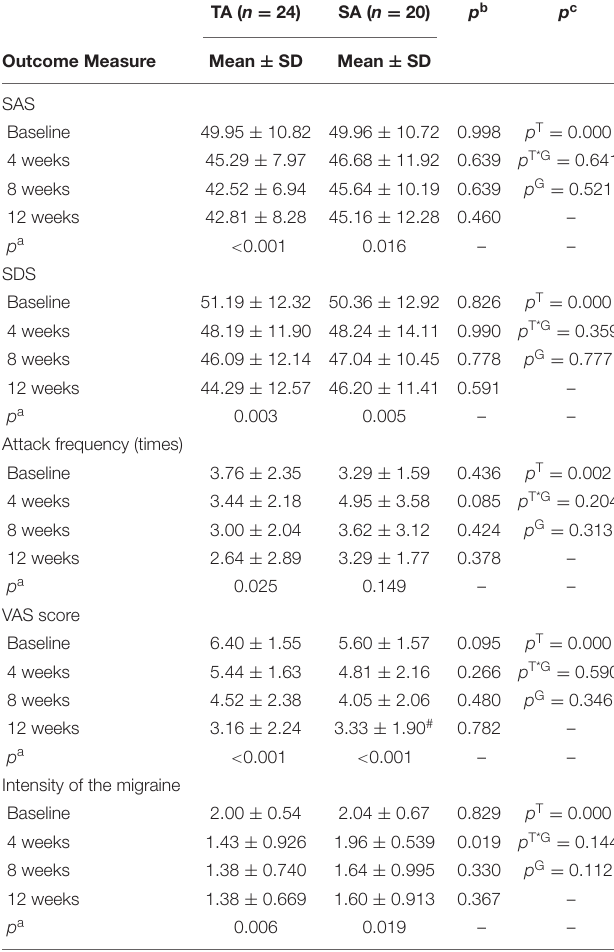
TABLE 4 | Clinical outcome measures in each